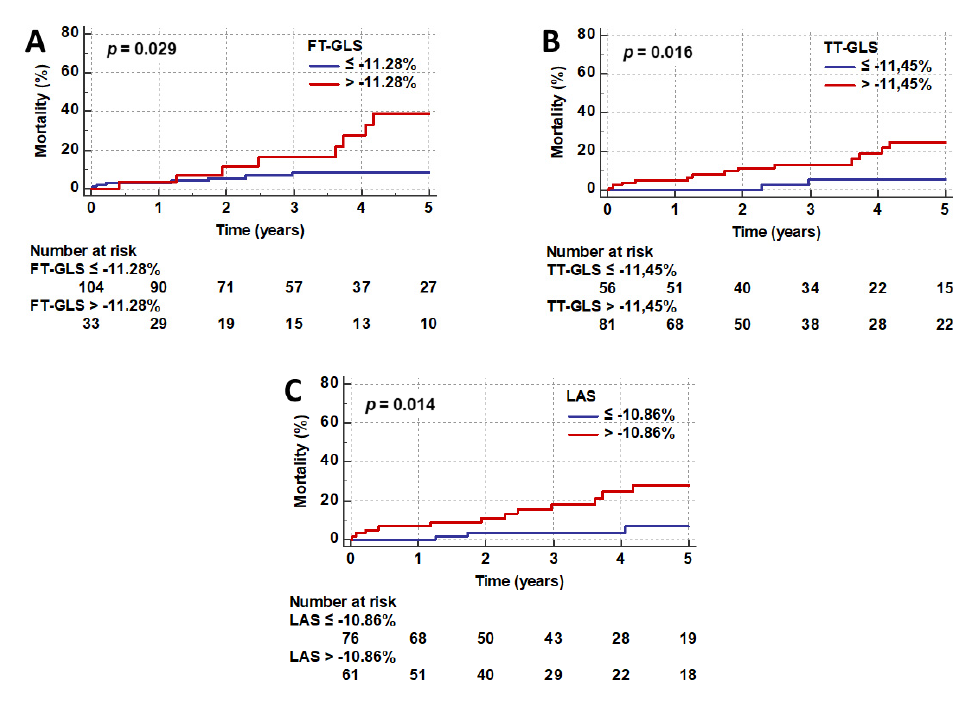
Figure 4. Kaplan–Meier plots. Long-term mortality rates after stratification according to the best cutoff values for FT-GLS ( A ), TT-GLS ( B ) and fast manual LAS ( C ). p -values were calculated with log-rank testing. FT = feature tracking; GLS = global longitudinal strain; LAS = long-axis strain; TT = tissue tracking.